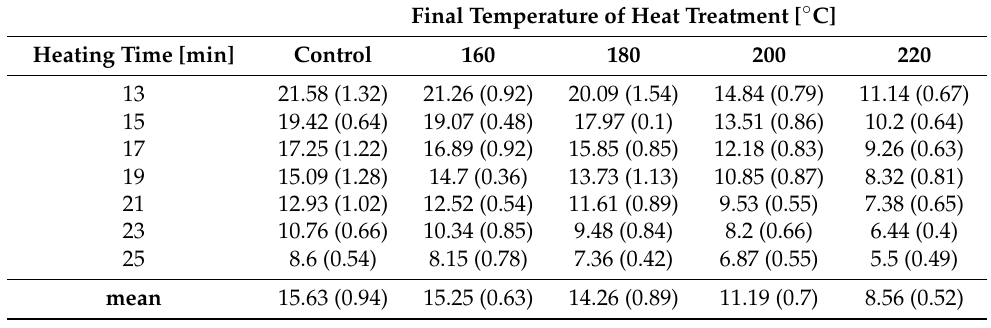
Table 2. Calculated values of the heat transfer coefficient α . Results are means (standard devia- tion).